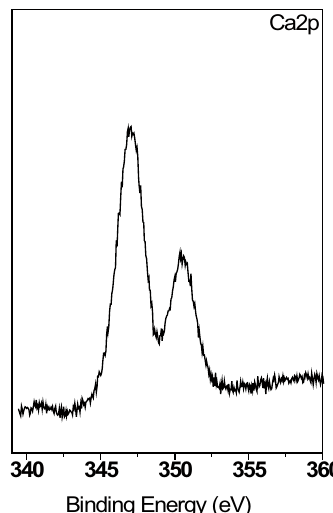
Figure 8. XPS Ca2p spectrum for G/S hybrid material 25:75 wt.% after immersion in 1.5 SBF for 3 days Table 1. Binding energy (eV) and relative concentration (at. %) of the elements detected on the surface of G/S hybrid material 75:25 wt.% after immersion in 1.5 SBF for 3 days Characteristics